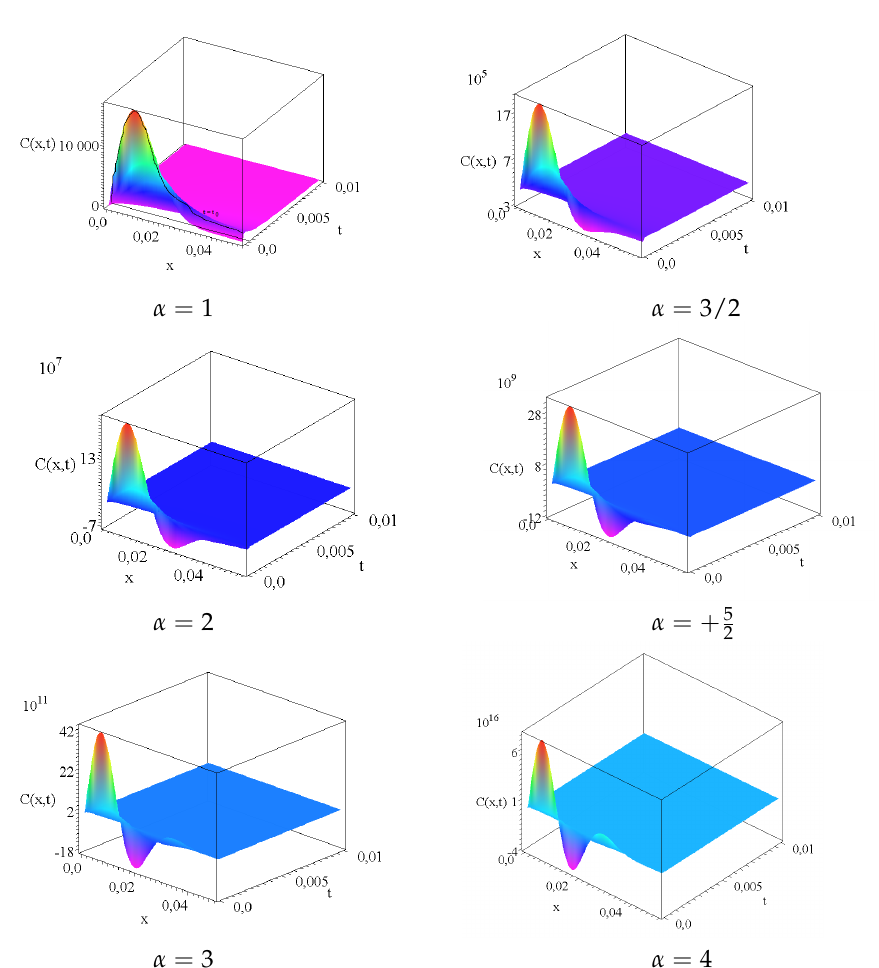
Figure 2. The total solutions C ( x , t ) with the shape function of Equation (5) for six various α values. For α = 1 a possible initial condition is given for t = t 0 with the black curve. Additional parameters D = 2, c 2 = 1, c 2 = 0 are the same in all cases. Note that for a better comparison the same ranges are taken for the spatial and temporal variables in all six